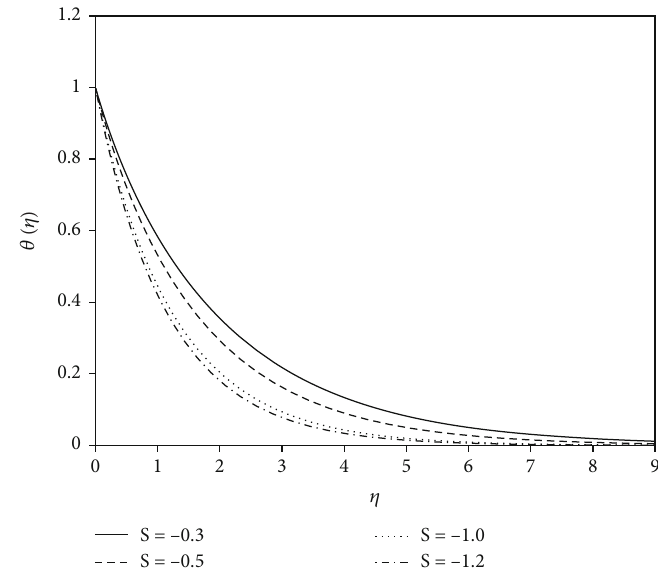
Figure 7: Di ff erent values of source parameter (sink) S on the temperature pro fi le.